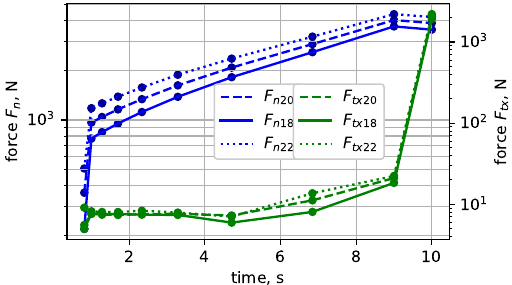
Figure 5. The model’s resulting forces on tyre vs time for displacement of 15 mm, tyre internal pressure 0.18, 0.2 and 0.22 MPa and tyre–road friction coefficient